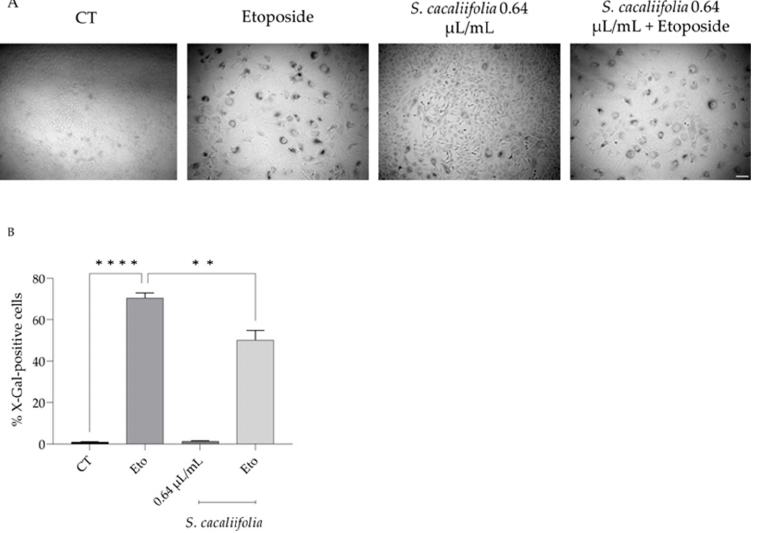
Figure 4. Effect of S. cacaliifolia essential oil on etoposide ‐ induced cell senescence. ( A ) Representative phase ‐ contrast images of NIH 3T3 fibroblasts treated with etoposide for 24h followed by a recovery period of 72h in the presence or absence of S. cacaliifolia essential oil. ( B ) Percentage of β‐ gal ‐ positive cells. The results show the mean ± SEM. ** p < 0.01, **** p < 0.0001 when compared to control (CT) or etoposide (Eto) after one ‐ way ANOVA followed by Dunnett’s multiple comparison test.